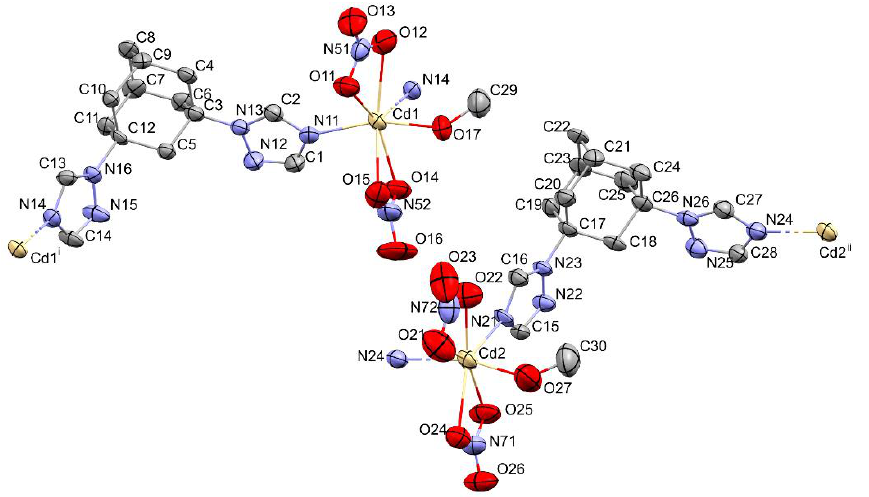
Figure 5. Fragment of crystal structure of coordination polymer 3 showing thermal ellipsoids (at 50% probability level) and labels for non-hydrogen atoms. Hydrogen atoms and uncoordinated CH 3 OH molecules are omitted for clarity. Symmetry operations: i ( x , y + 1, z ); ii ( x , y − 1, z ).